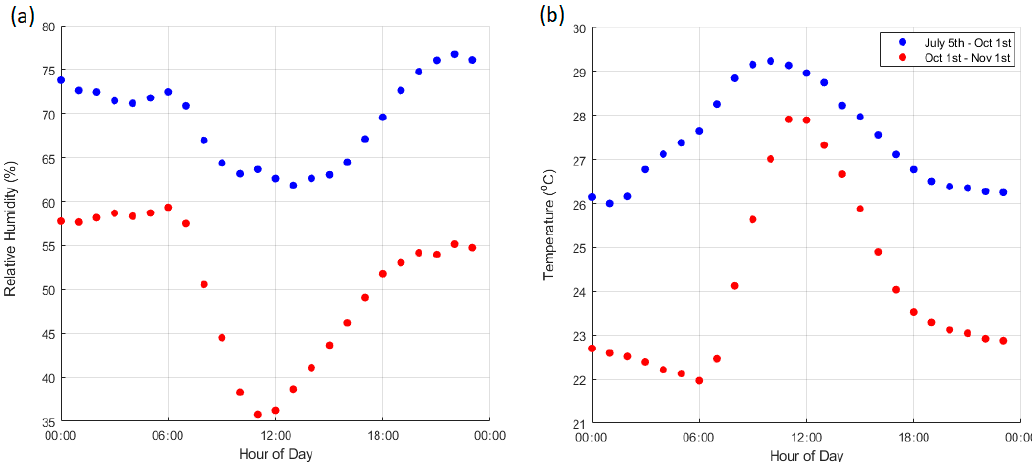
Figure 2. Average diurnal patterns for relative humidity ( a ) and temperature ( b ) recorded at the sampling site. Averages are taken for two periods, with 5th July–1st October shown in blue and 1st October onwards shown in red.